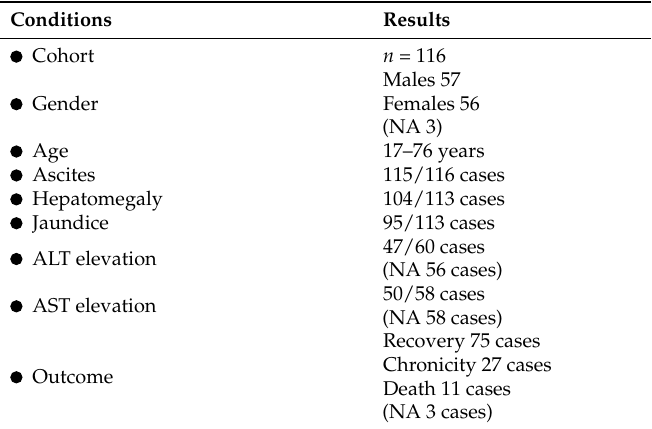
Table 6. Clinical characteristics of the hepatic sinusoidal obstructive syndrome (HSOS) caused by Gynura segetum containing unsaturated